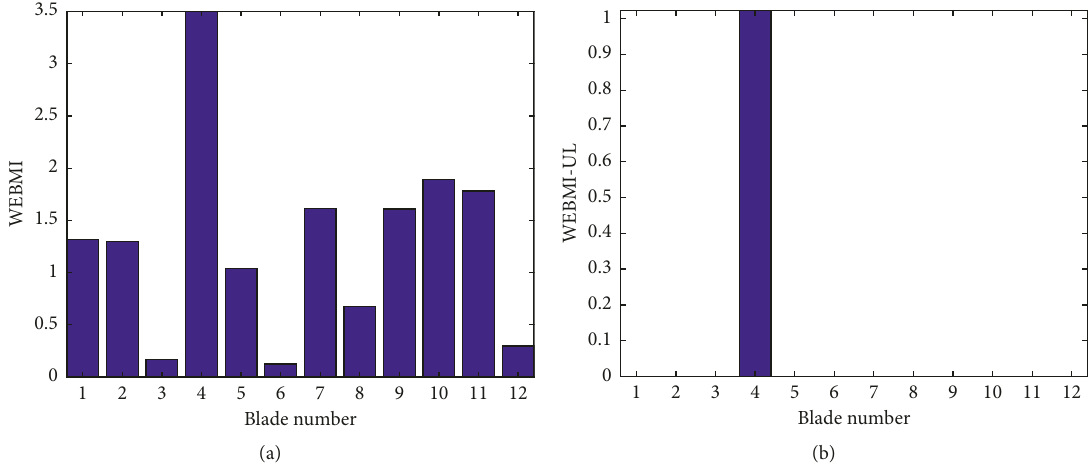
Figure 20: PECS results for the added mass located at blades 4 and 8. (a) WEBMI and (b) WEBMI-UL.